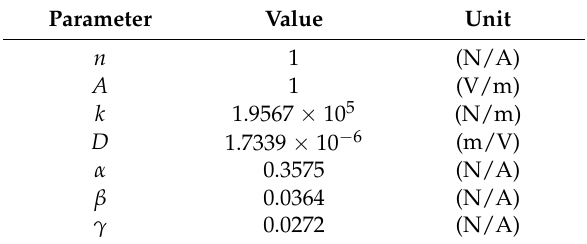
Table 1. Identified parameters for the driven piezoelectric material with a Bouc–Wen model.